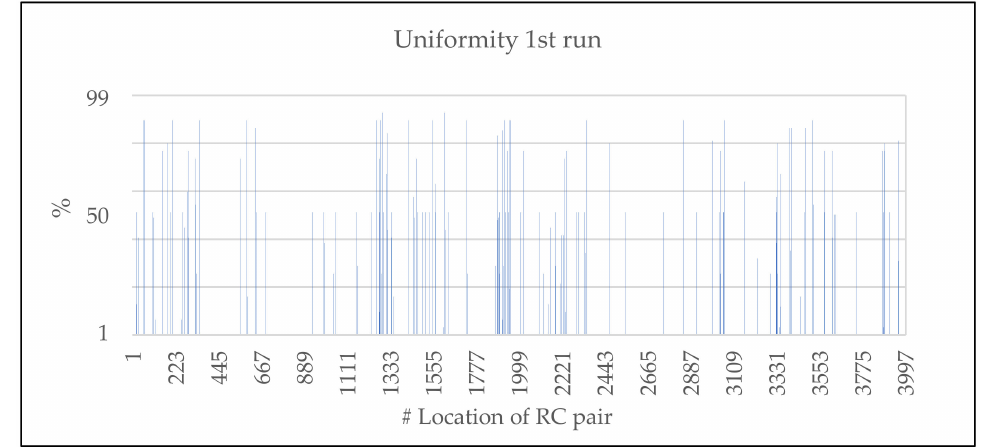
Figure 5. Uniformity of the RC pairs on first